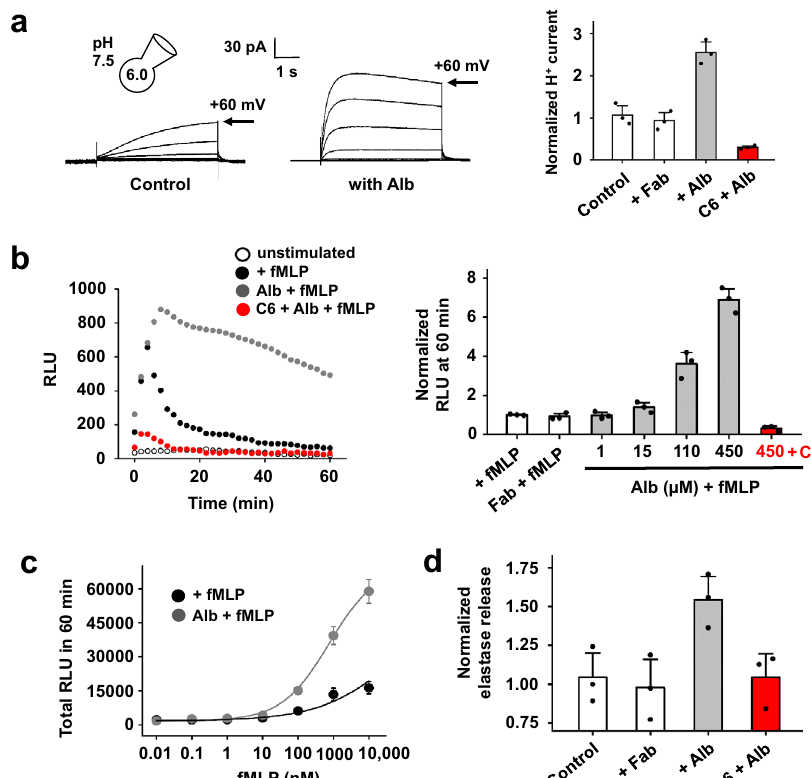
Fig. 2 Alb activates hHv1 in human neutrophils to increase ROS production and elastase release. a Proton currents passed by hHv1 in human neutrophils studied in the absence (left) and presence (middle) of 450 μ M Alb (steps from − 60 and + 60 mV in 20 mV increments). Fitting activation and deactivation of currents at + 60 mV offered time constants (Supplementary Table 1). Right, hHv1 currents measured at the peak of a test pulse to + 60 mV after exposing neutrophils to 450 μ M Fab (white bar), 450 μ M Alb (gray bar), or 450 μ M Alb + 20 μ M C6 (red bar). Values are normalized to mean current amplitude in the absence of Alb. C6 peptide blocked 87 ± 2% of of the current activated by Alb, n = 3 cells. b Left, effect of fMLF alone or in combination with Alb on ROS production by human neutrophils. Human neutrophils (2 × 10 5 cells) were incubated without or with 450 μ M Alb, then stimulated with 1 μ M fMLF. ROS was measured using luminol (relative light units, RLU). ROS production from unstimulated neutrophils is negligible (white circles). Alb (gray circles) enhanced and sustained the fMLF-stimulated ROS production compared to neutrophils stimulated with fMLF alone (black circles). Incubation with 20 μ M C6 (red circles) inhibited ROS production potentiated by 450 μ M Alb. Right, ROS produced 60 min after fMLF stimulation. Incubation with Alb increased ROS production by human neutrophils (gray bars); addition of C6 (20 μ M, red bar) inhibited the ROS production potentiated by 450 μ M Alb. 450 μ M Fab had no effect on fMLF-stimulated ROS production (white bar). Values are normalized to mean ROS production by neutrophils stimulated with fMLF alone, n = 3 independent experiments. c Human neutrophils (2 × 10 5 cells) were incubated without (black circles) or with 450 μ M Alb (gray circles) and then stimulated with increasing concentrations of fMLF. ROS were measured as described in ( b ). Some error bars are smaller than symbols, n = 3 independent experiments. d Human neutrophils (6 × 10 5 cells) were incubated with Alb and then stimulated with 1 μ M fMLF. Total elastase release at each test condition was measured spectrophotometrically. The values are normalized to elastase release stimulated with fMLF alone (Control, white bar). A 450 μ M Alb increased the elastase release by neutrophils (gray), and the increase was inhibited by 20 μ M C6 (red) whereas 450 μ M Fab had no effect on fMLF-stimulated elastase release (white bar), n = 3 independent experiments. Values are mean ± SEM. Source data are provided in the Source Data fi